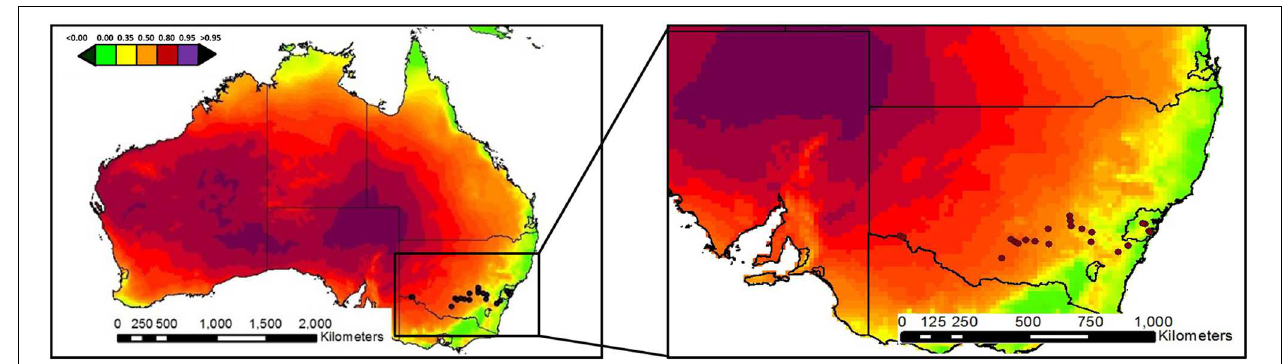
FIGURE 1 | Locations of the study sites. Color patterns indicate aridity (1 – aridity index) gradients. Aridity increases from green to purple in the